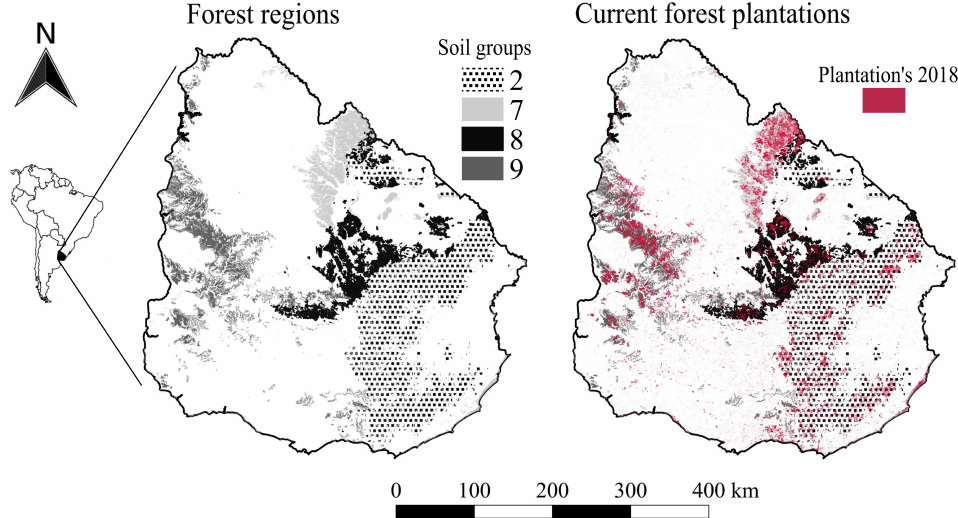
Figure 2. Left map: Regions prioritized for forest plantations (black and gray patterns) according to the National Commission for Agroeconomic Studies of the Land Classification (CONEAT), soils corresponding to groups 2, 7, 8, and 9 have adequate soil fertility for forest plantation. Right map: The current forest plantations (red) reported by the Forestry Directorate (DGF) (Ministry of Cattle, Agriculture, and Fisheries, MGAP)